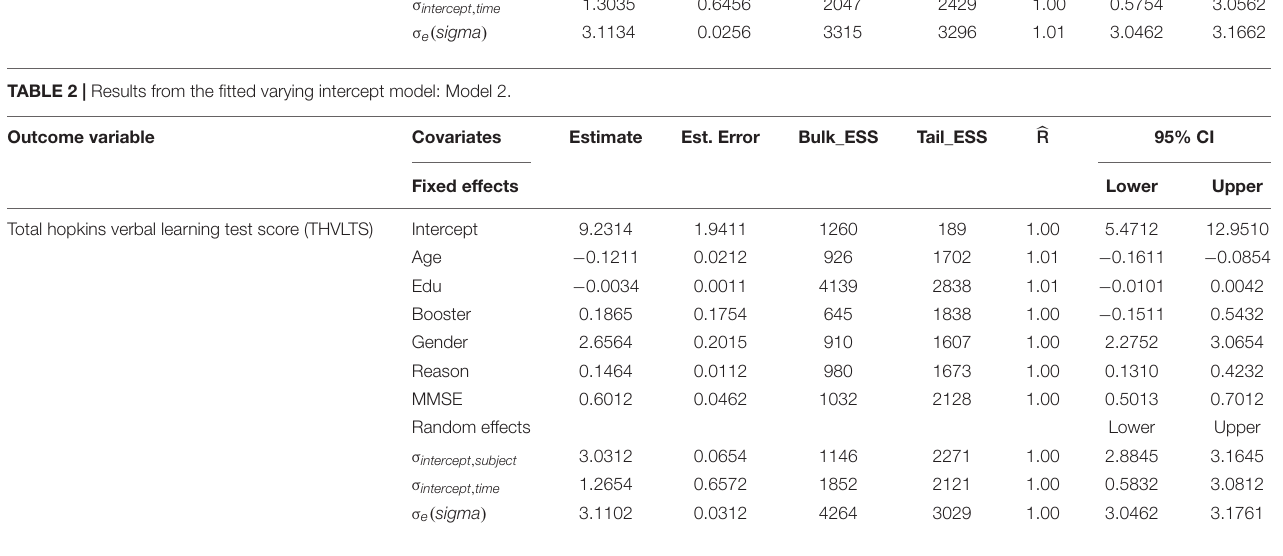
TABLE 2 | Results from the fitted varying intercept model: Model 2. Outcome